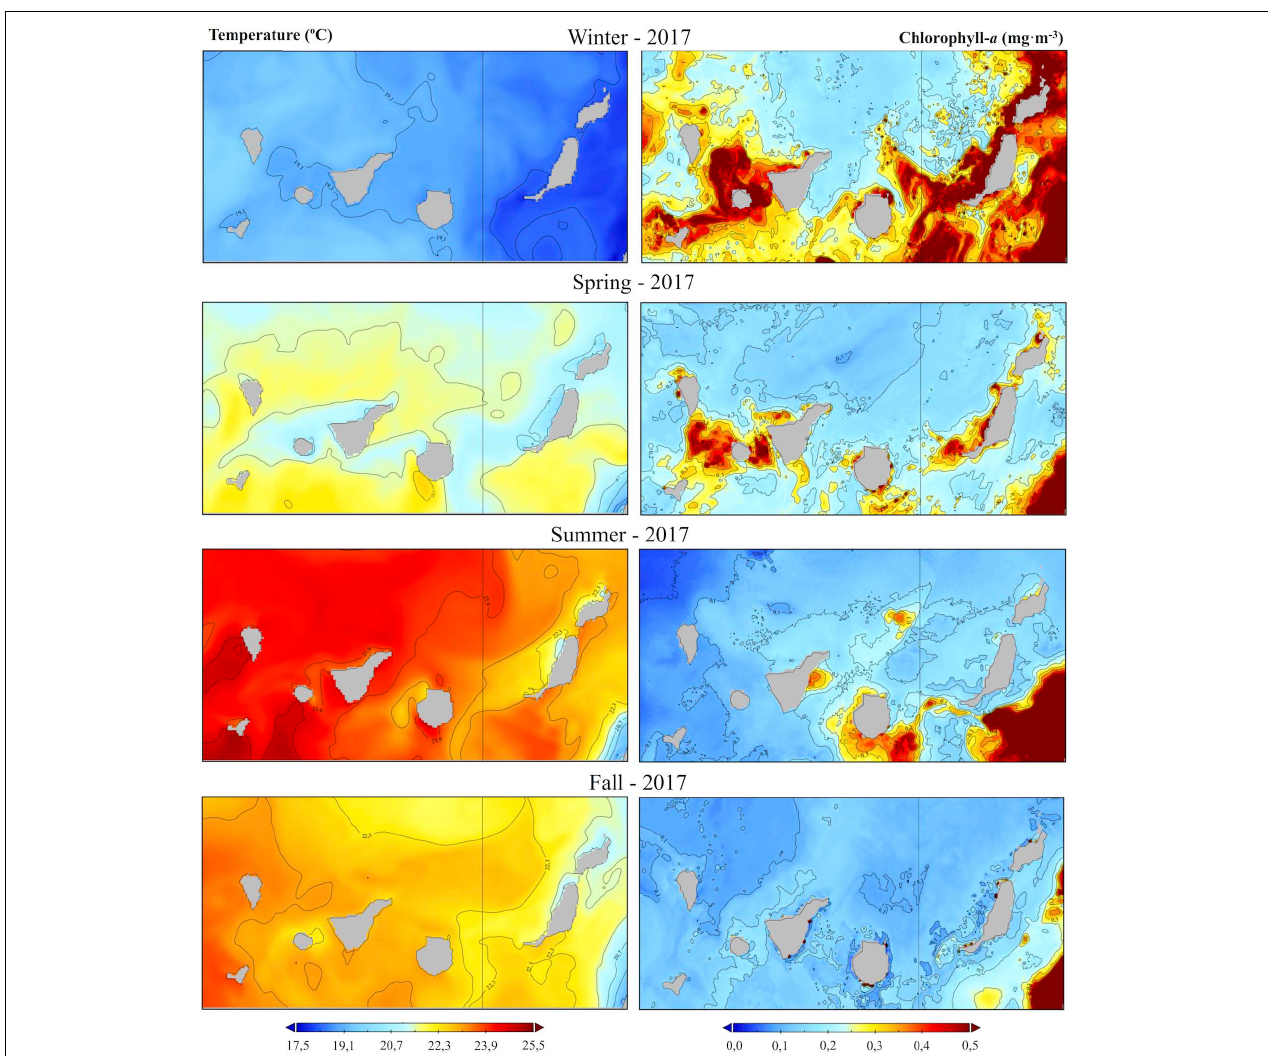
FIGURE 2 | Environmental and biological variables. Left panels: sea surface potential temperature (SST, ◦ C); right panels: chlorophyll- a (Chl- a , mg · m − 3 ; an example from 2017 (http://marine.copernicus.eu/).